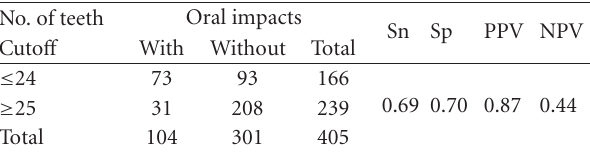
Table 2: Diagnostic performance of 24/25 natural teeth in detecting those with/without oral impacts in 40–59 year olds.